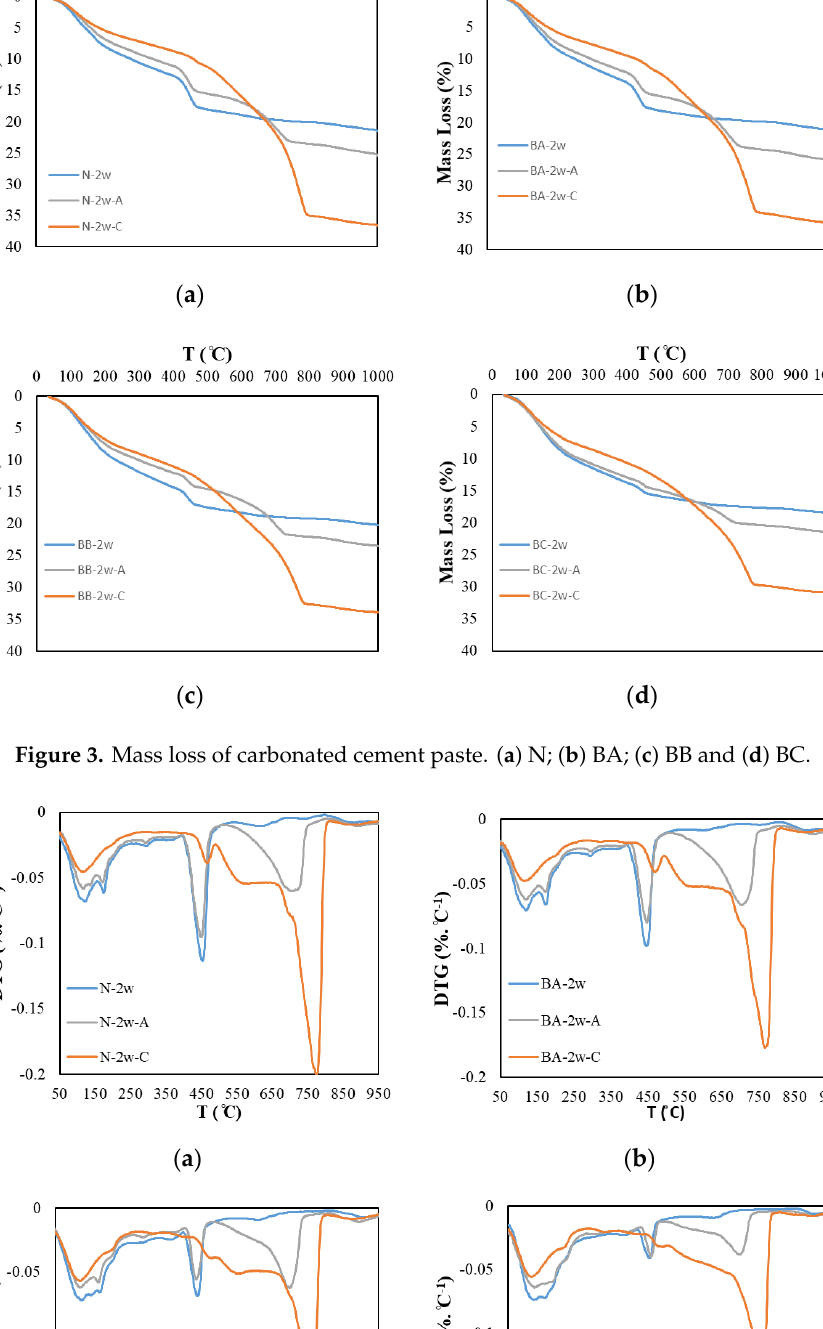
Figure 4. DTG of carbonated cement paste. ( a ) N; ( b ) BA; ( c ) BB and ( d ) BC.